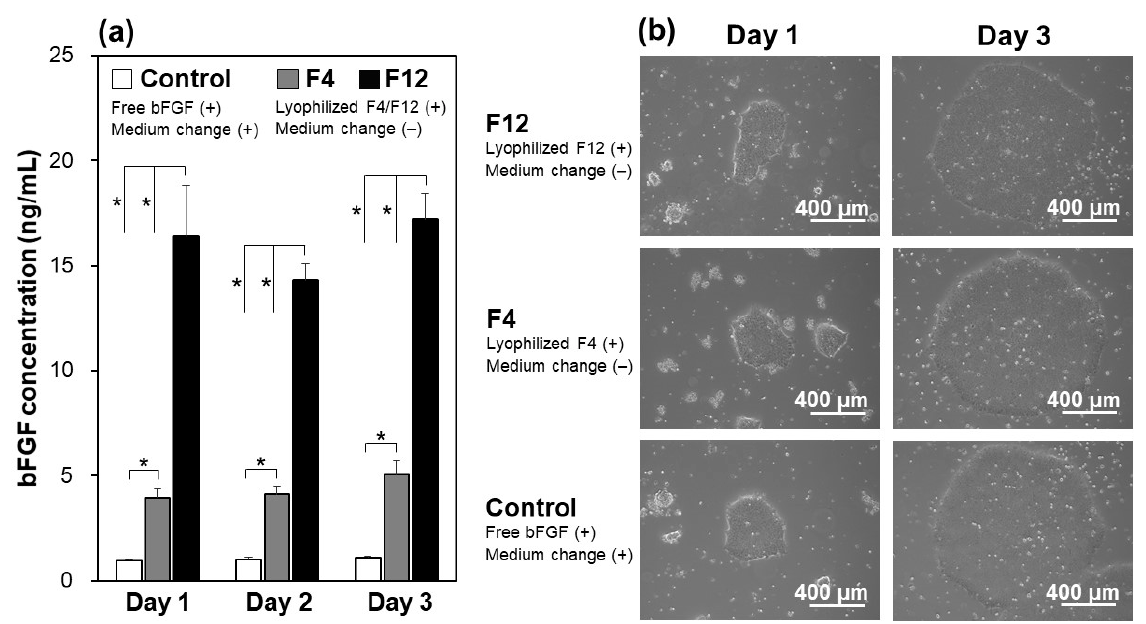
Figure 5. ( a ) Concentrations of bFGF in the culture medium of human iPSCs on Days 1, 2, and 3, in the medium-change-free continuous culture with the lyophilized F4 membrane (F4 group; gray bars) or F12 membrane (F12 group; black bars), or in standard culture using the bFGF-containing medium with daily medium refreshment (control group; white bars) (average + SD; n = 3; * p < 0.05), and ( b ) phase contrast microscopic images of human iPSCs on Days 1 and 3 in the control, F4, and F12 groups.